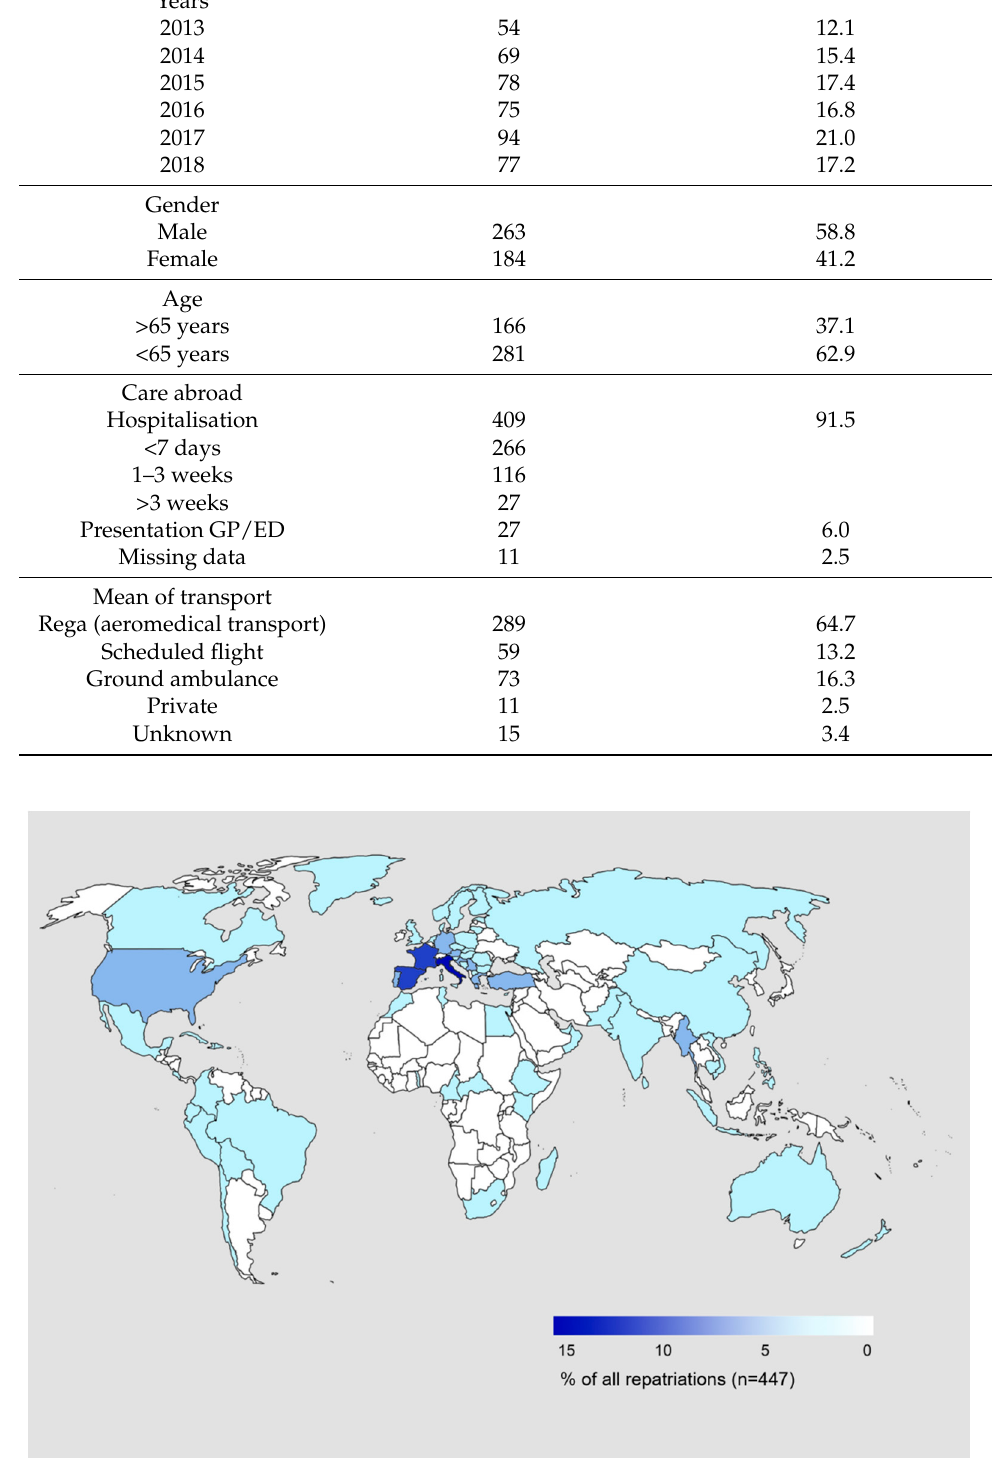
Figure 3. Illustration of repatriation countries by percentage.